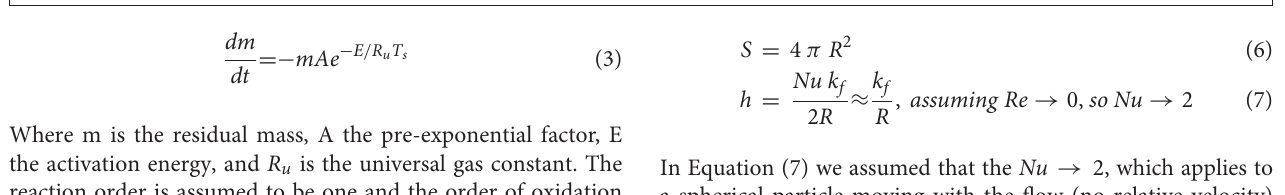
FIGURE 1 | Overview of the two methodologies for estimating thermal lag in the literature. Both the method by Antal and Bilbao use an energy balance at the surface of the particle (assume lumped capacitance) as a thermal model, but Antal finds the source term from a kinetic model, while Bilbao finds the source term from a